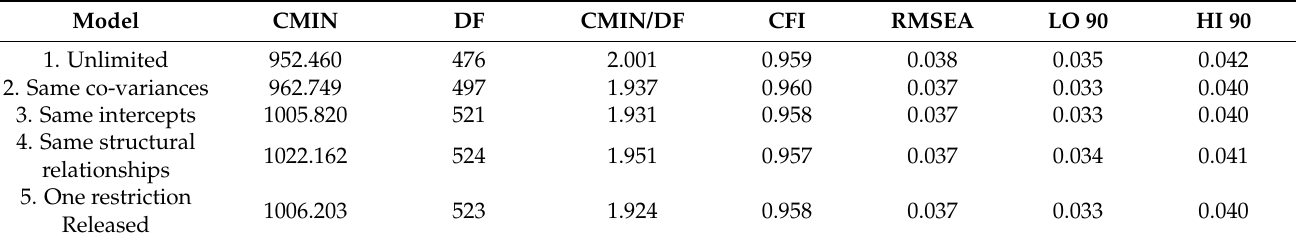
Table 6. Comparison of the fit of the multi-group structural equation models.